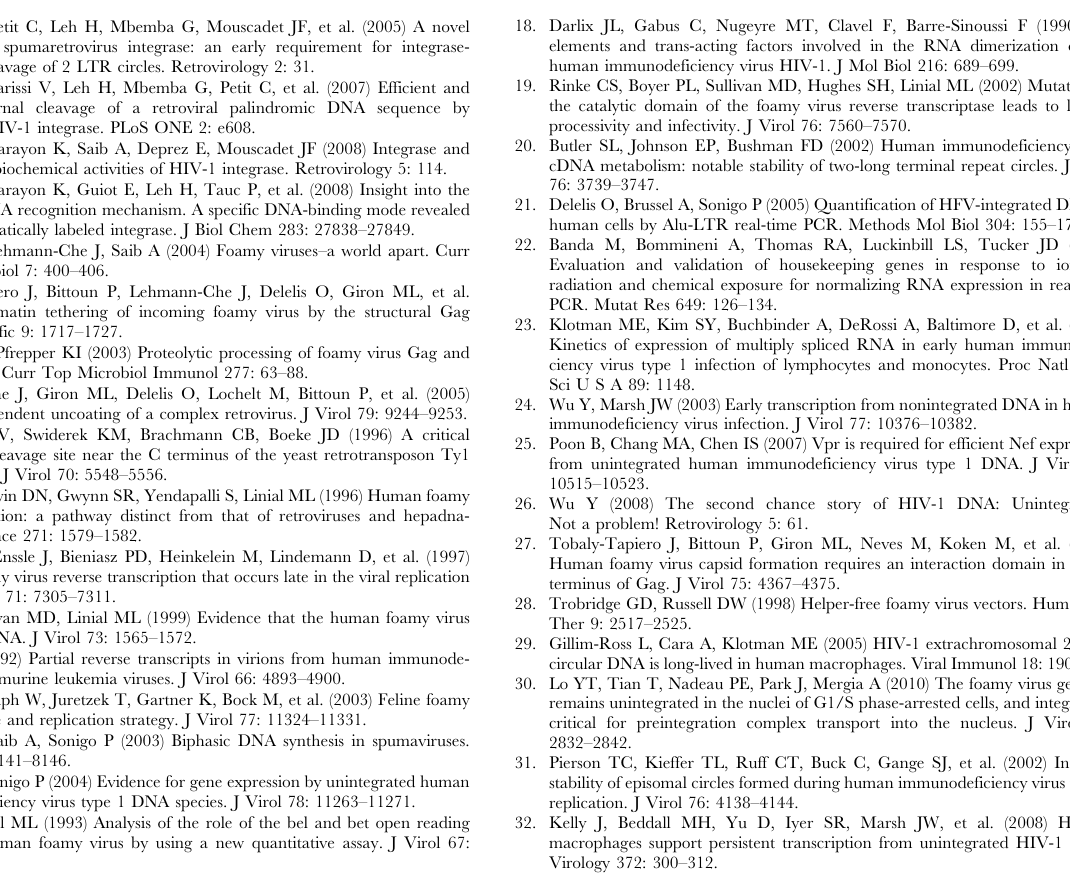
Figure S1 Real-time PCR and RT-PCR strategies for the PFV- 1 RNA and DNA quantification. Primers used to quantify total viral DNA (A) are located in the gag gene. Primers spanning the LTR-LTR junction were used to detect 2-LTR circles (B). Integrated DNA (C) is measured by two rounds of PCR as described previously [21]. Viral RNA species are depicted (D). Primers used in the RT-PCR strategy monitored all viral RNA species. Found at: doi:10.1371/journal.pone.0011023.s002 (1.27 MB